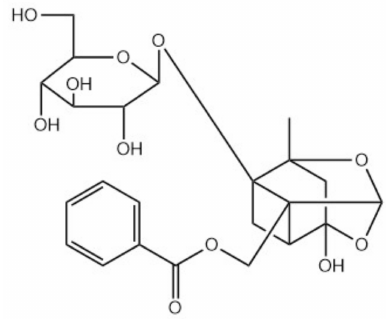
Figure 7. Chemical structure of